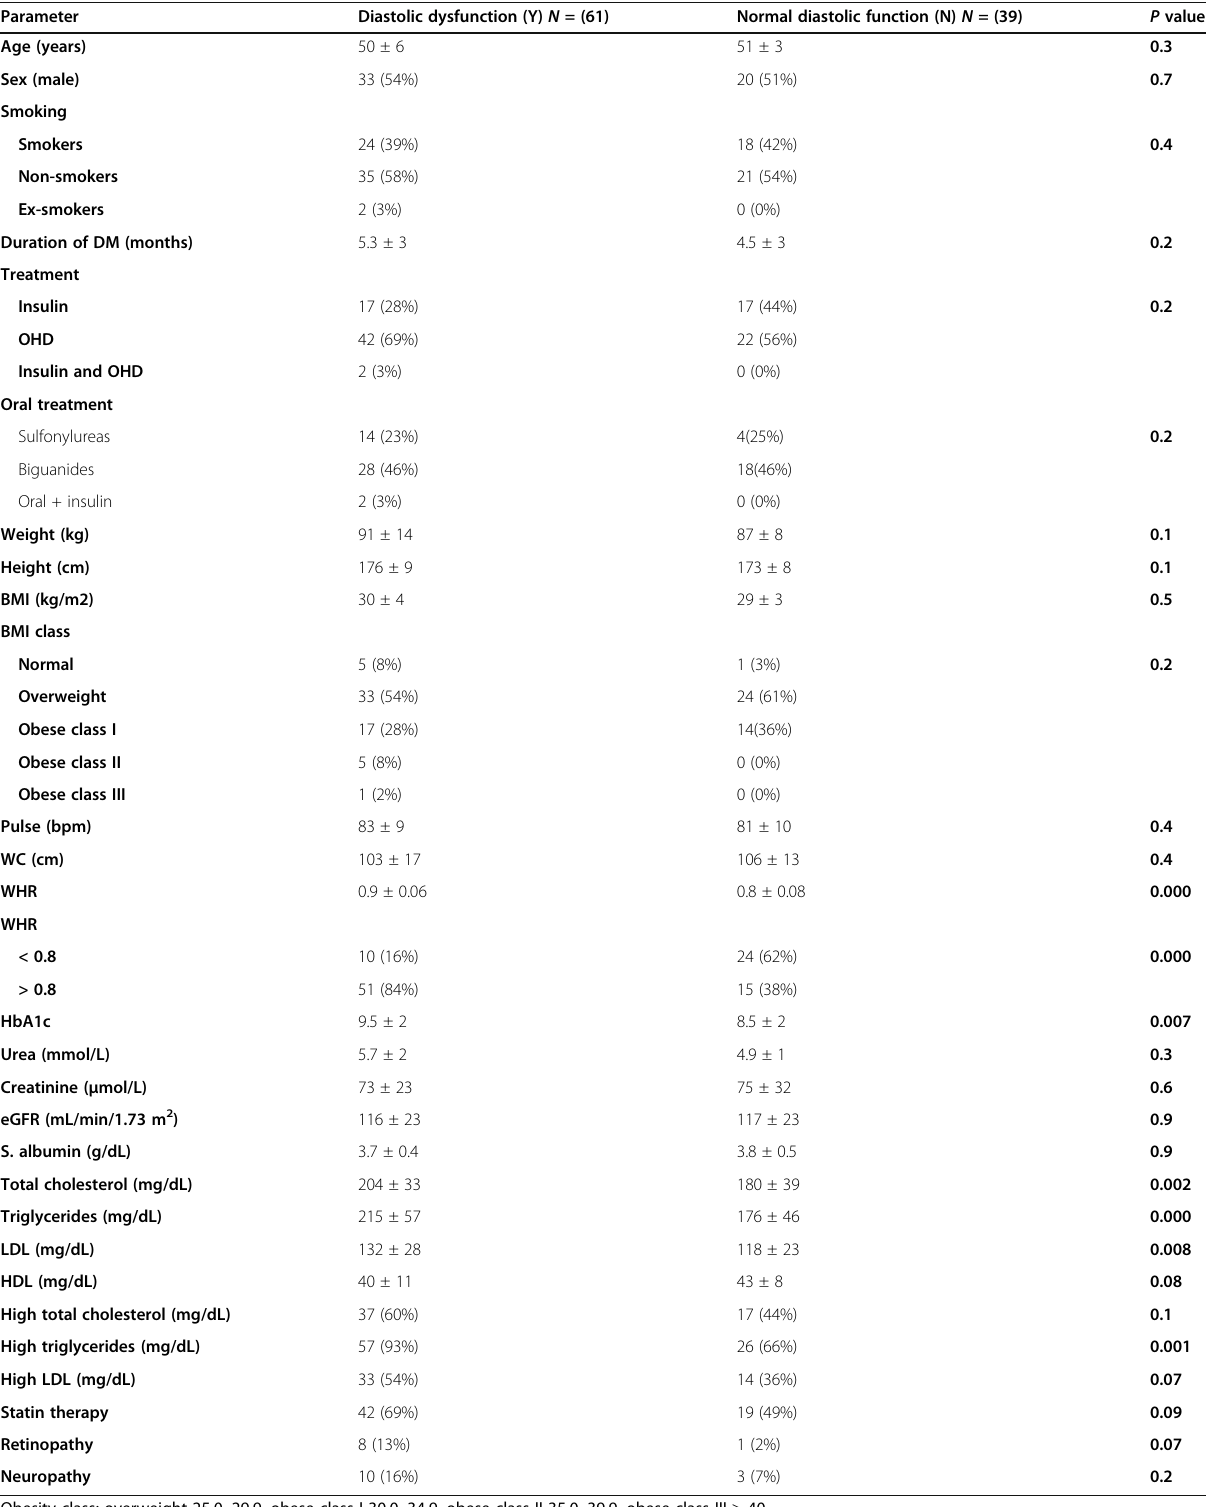
Table 3 Comparison between baseline and laboratory characteristics of the study group classified according to presence or absence of diastolic